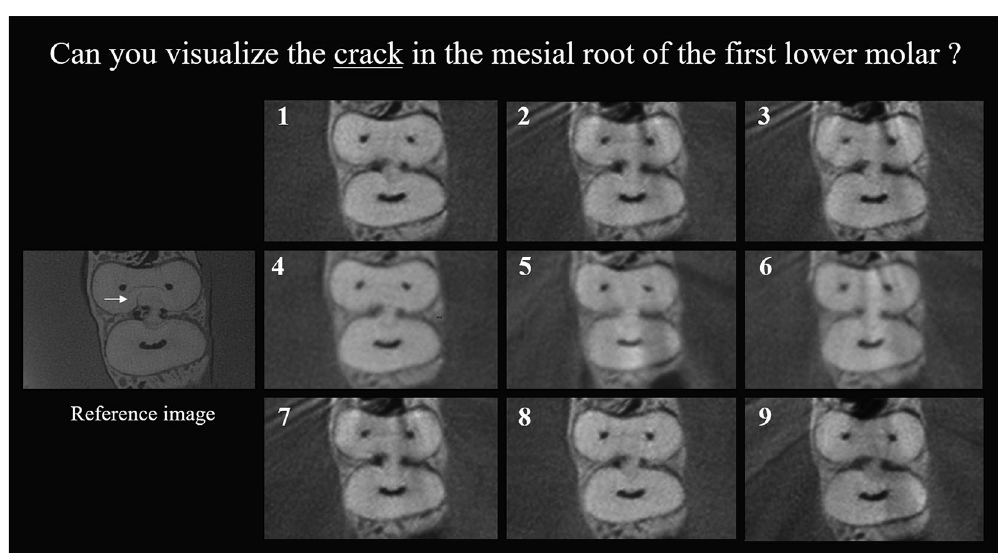
Figure 3. Set of images used for crack assessment containing a reference image from industrial CT and numbered images of X1 CBCT device for all conditions and scanning